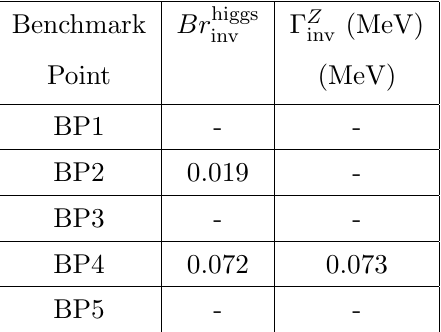
Table 6 . Invisible Higgs branching ratio and invisible Z decay width for di(cid:11)erent benchmark points tabulated in table 2. \-" stands for cases where M > m Z = 2 and/or > m h = 2. 1 1 with c = m =m is the Weinberg angle where m is the mass of SM W ( Z ) boson. W W Z W ( Z ) Now, for our chosen BPs we would like to see whether these bounds are applicable or not. First note that, Higgs invisible decay is possible for BP2 and BP4, while Z can decay invisibly to DM pairs only for BP4. Rest of the benchmarks are safe from such bounds as DM mass is much above than SM Higgs or SM Z mass. In table 6 we have tabulated the invisible branching fraction ( Br higgs ) for SM Higgs (left column) and invisible Z decay inv width (cid:0) Z for SM Z (right inv